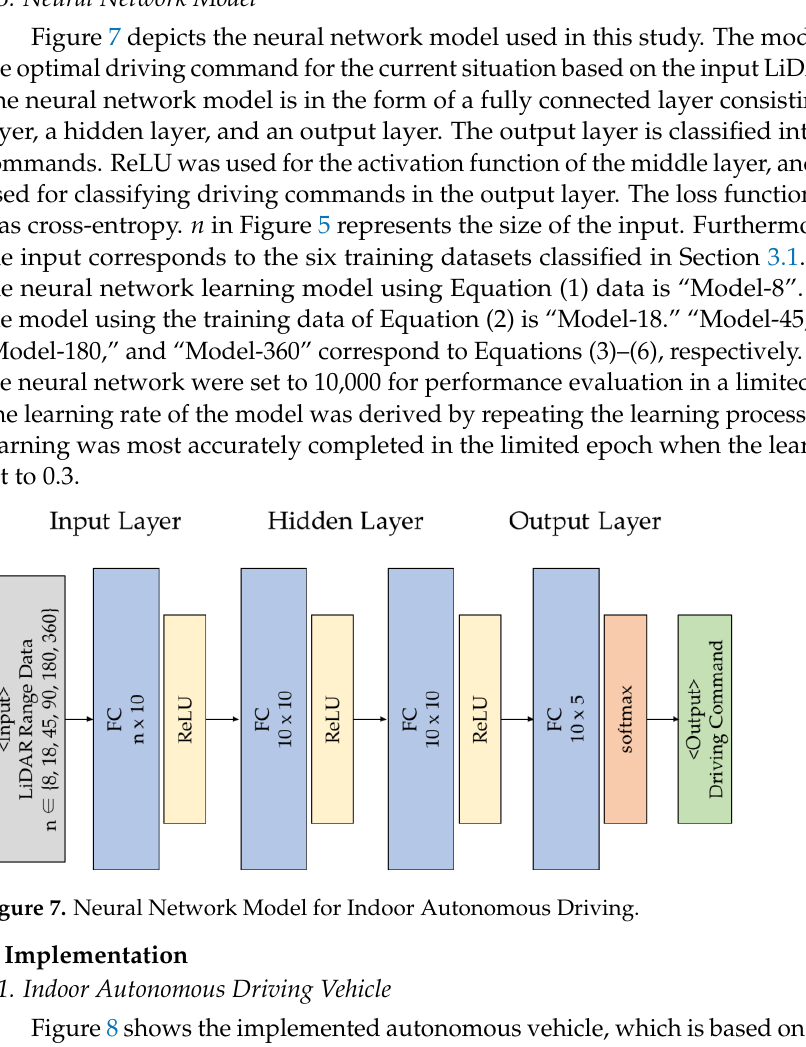
Figure 6. Normalized Range Data with Denoising.